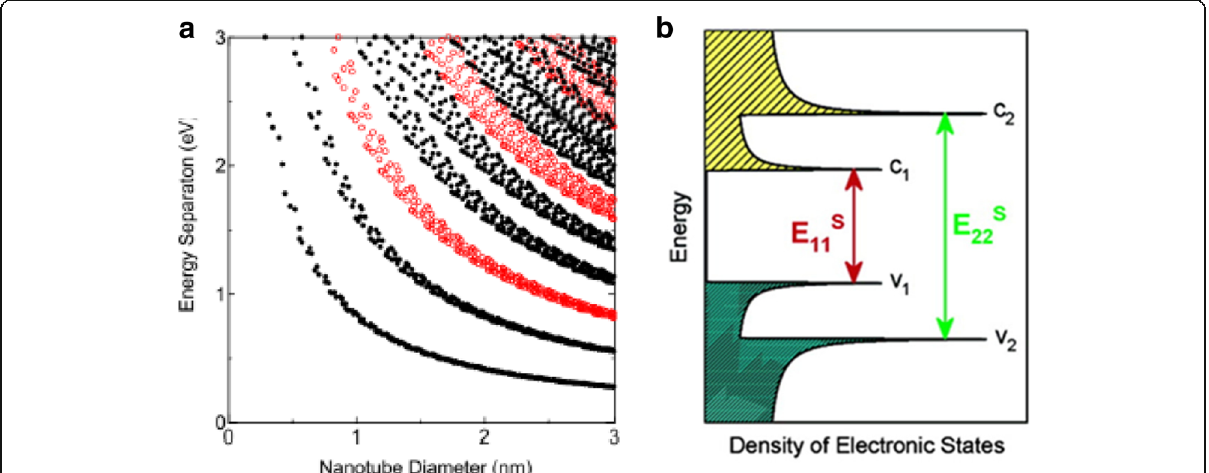
Fig. 2 a Kataura plot relating the energy of the band gaps in a carbon nanotube and its diameter. Here, red circles denote semiconducting CNTs and black circles denote metallic CNTs. Adapted from [32]. b Schematic showing the density of states and VHS peaks (indicated by a sharp maxima) of a semiconducting CNT. Arrows indicate the mechanism of light absorption and emission. Adapted from